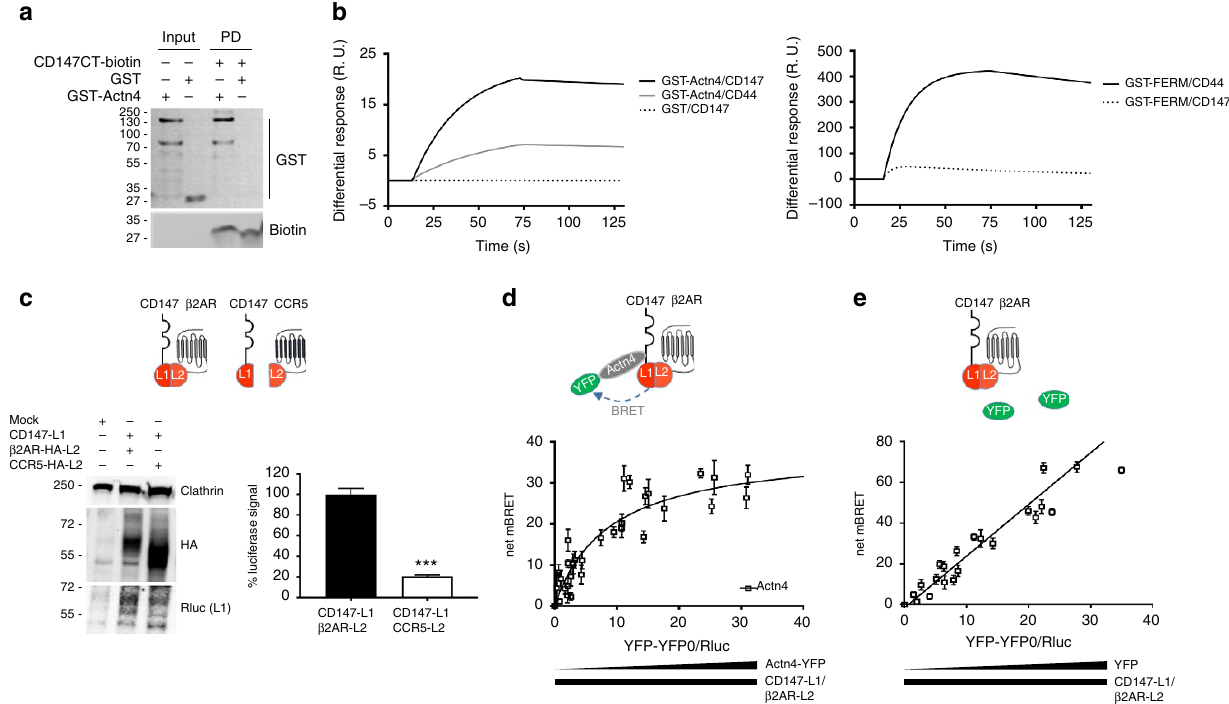
Figure 3 | a -Actn4 associates with CD147– b 2 AR complexes. ( a and b ) Purified Actn4 directly binds to the cytosolic domain of CD147. ( a ) Pull-down (PD) assay: purified GST–Actn4 fusion protein or GST alone was incubated with biotinylated peptides comprising the cytosolic tail of CD147 (CD147-CT) immobilized on streptavidin beads. Precipitated samples were successively immunoblotted with anti-GST (top) and anti-biotin antibodies (bottom). Input GSTproteins were loaded as a control (right lanes). The uncropped blots are shown in Supplementary Fig. 11. ( b ) Surface plasmon resonance analysis of the interaction between Actn4 and the cytosolic domain of CD147 in non-reducing buffer conditions. Left panel: Sensorgrams showing binding of GST–Actn4 fusion protein or GSTalone (200nM) to the cytosolic tail of CD147 or of CD44 as a control. Right panel: Control sensorgrams showing binding of the ezrin FERM domain in fusion with GST to the cytosolic tail of CD147 and CD44. ( c – e ) CODA-RET characterization of Actn4 interaction with CD147– b 2AR complexes. ( c ) Constructs used for the CODA-RETassays: CD147 was fused to the N-terminal fragment of Renilla luciferase (CD147-L1) and the b 2 AR to the C-terminal fragment ( b 2 AR-L2). As a control, CCR5 was also fused to the C-terminal fragment (CCR5-L2). (Left panels) The coexpression of the different constructs was confirmed by western blot analysis with anti-HA and anti-Rluc (L1) antibodies. The uncropped blots are shown in Supplementary Fig 12. (Right panel) Luciferase assays: HEK293 cells were co-transfected with varying ratios of CD147-L1 and b 2 AR-L2 or CCR5-L2 and 24h after transfection coelenterazine h was added to measure the luciferase activity. Optimal results were obtained for a CD147: b 2AR ratio equivalent to 9:1. Results correspond to the mean ± s.e.m. of n ¼ 4 independent experiments. ( d and e ) CODA-RETassays: Actn4 was fused to YFP at its N terminus. HEK293 cells were co-transfected with CD147-L1 (50ng), b 2 AR-L2 (450ng) and increasing amounts (0–400ng) of Actn4-YFP or YFP. At 24h after transfection, coelenterazine h (Rluc substrate) was added to measure the BRETsignal. The results correspond to the mean ( ± s.e.m.) of four independent